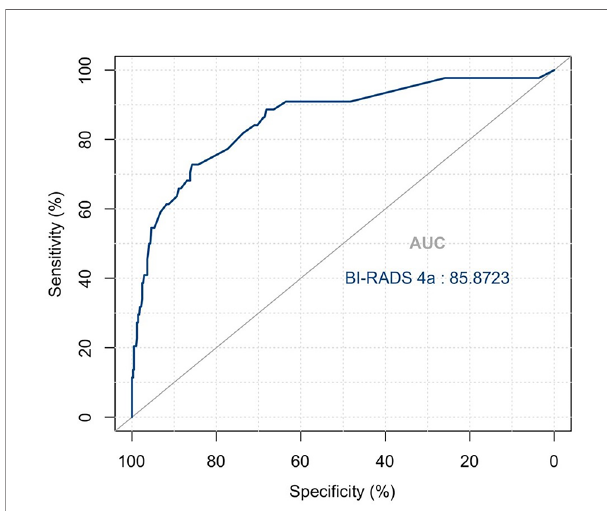
FIGURE 2 | ROCcurvefor predictingbenignandmalignantmassesincategory